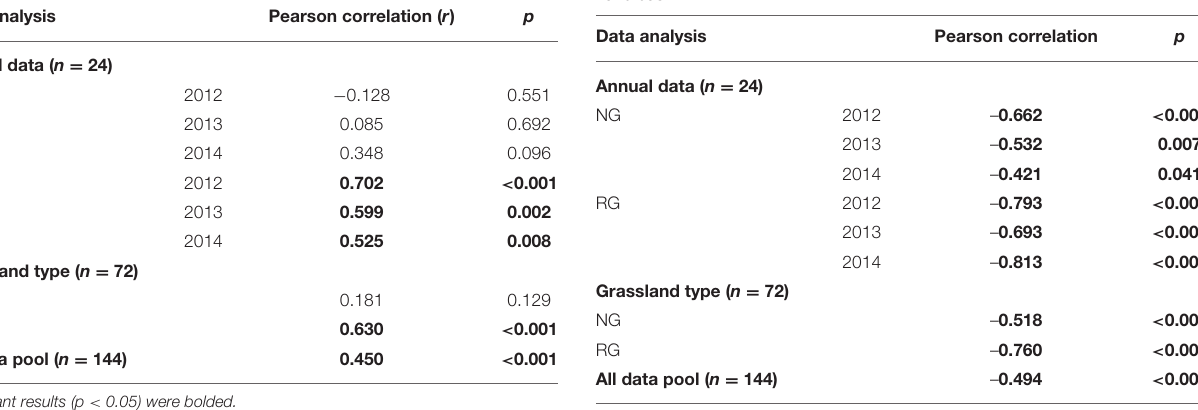
TABLE 4 | Correlations between the ratio of root and shoot and aboveground biomass in the natural (NG) and restored (RG) alpine grasslands around Qinghai Lake basin.